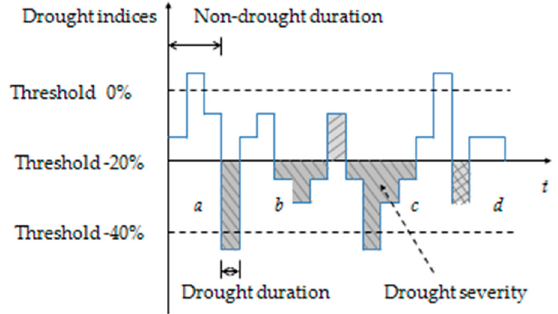
Figure 1. Schematic diagram of drought identification.